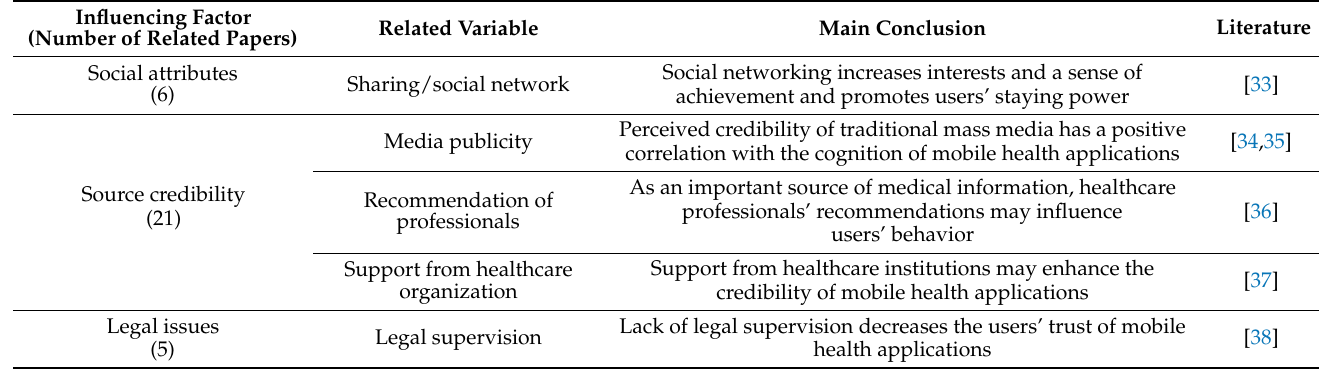
Table 3. Influence of social factor in use